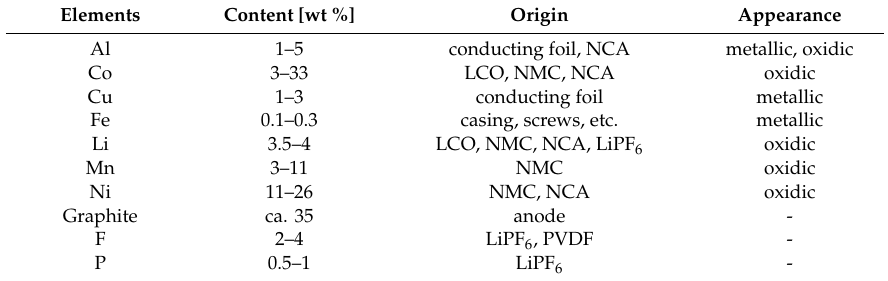
Table 6. Concentration ranges of major black mass components produced from layered oxides chemistries (see Section 2), adapted from [69,78,79]. LiPF 6 : lithium hexafluorophosphate, PVDF: polyvinylidene